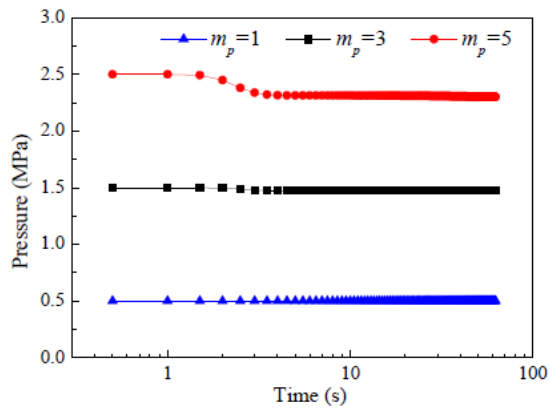
Figure 16: Pressure at the inlet during start-up